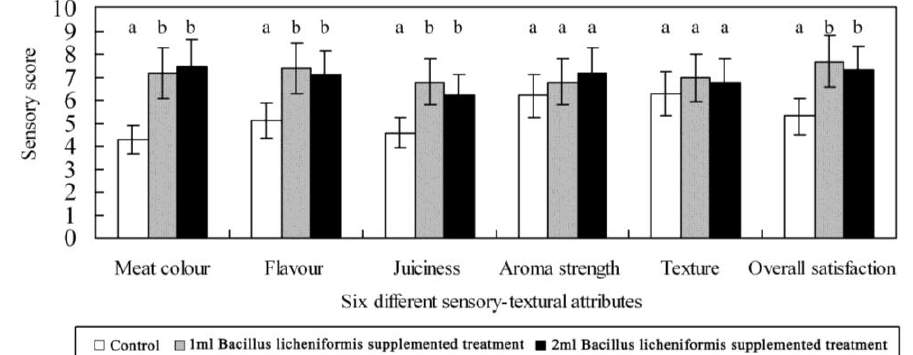
Figure 3. Comparison of meat colour, flavour, juiciness, aroma strength, and texture of chicken breast fillet between the control group and Bacillus licheniformis treated groups. Each column represents the mean of 15 observations; meat colour, flavour, juiciness, aroma strength, and texture were assessed by the sensory panel using a hedonic (1 to 9) scale where the meat colour ranged from extremely light to extremely dark, flavour from extremely unpleasant to extremely enjoyable, juiciness from extremely dry to extremely juicy, aroma strength from very weak to very strong, and texture from extremely gooey to extremely smooth. Error bars represent standard deviations (n = 15).